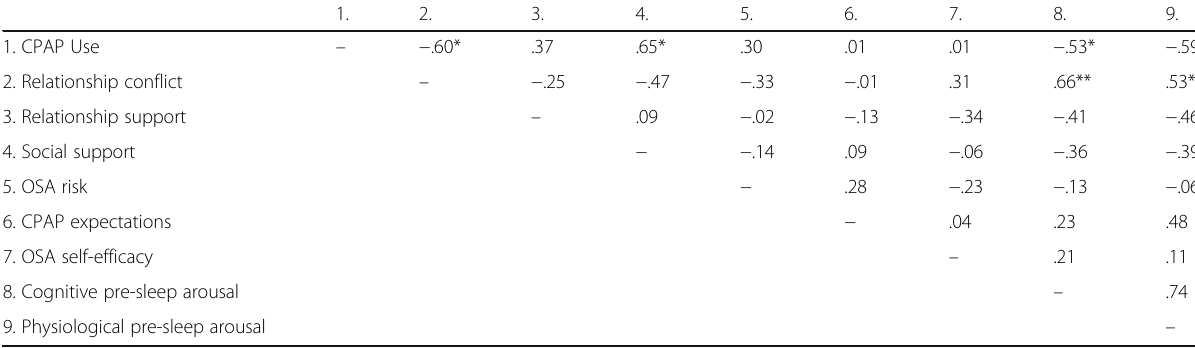
Table 3 Correlations between CPAP use, relationship quality and social support